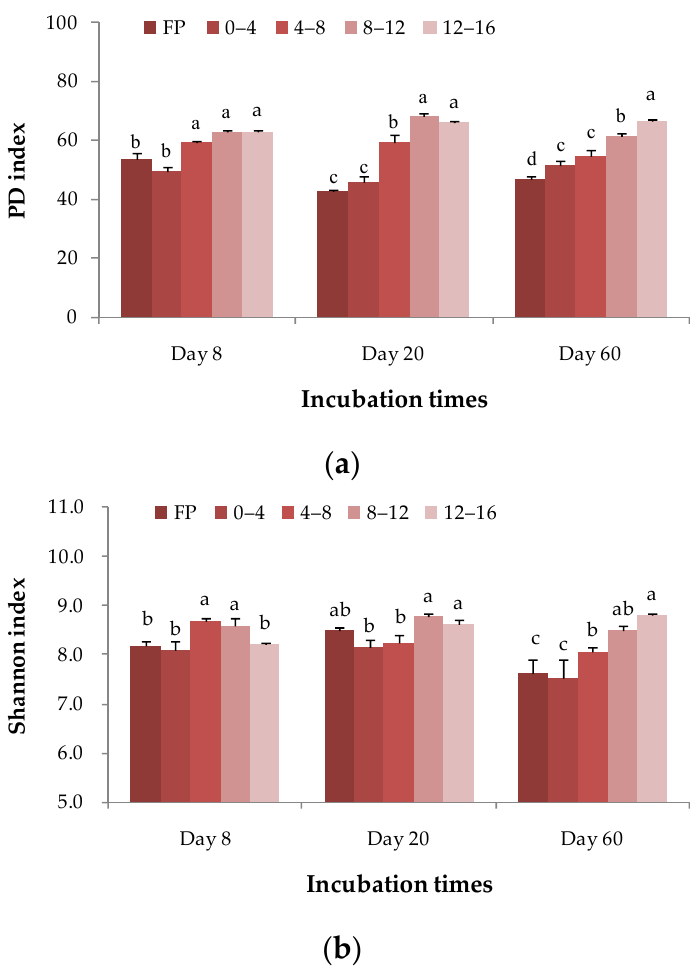
Figure 5. Bacterial α -diversity in response to different treatments for Dangtu (DT) soil. ( a )